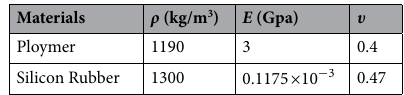
Table 1. Material